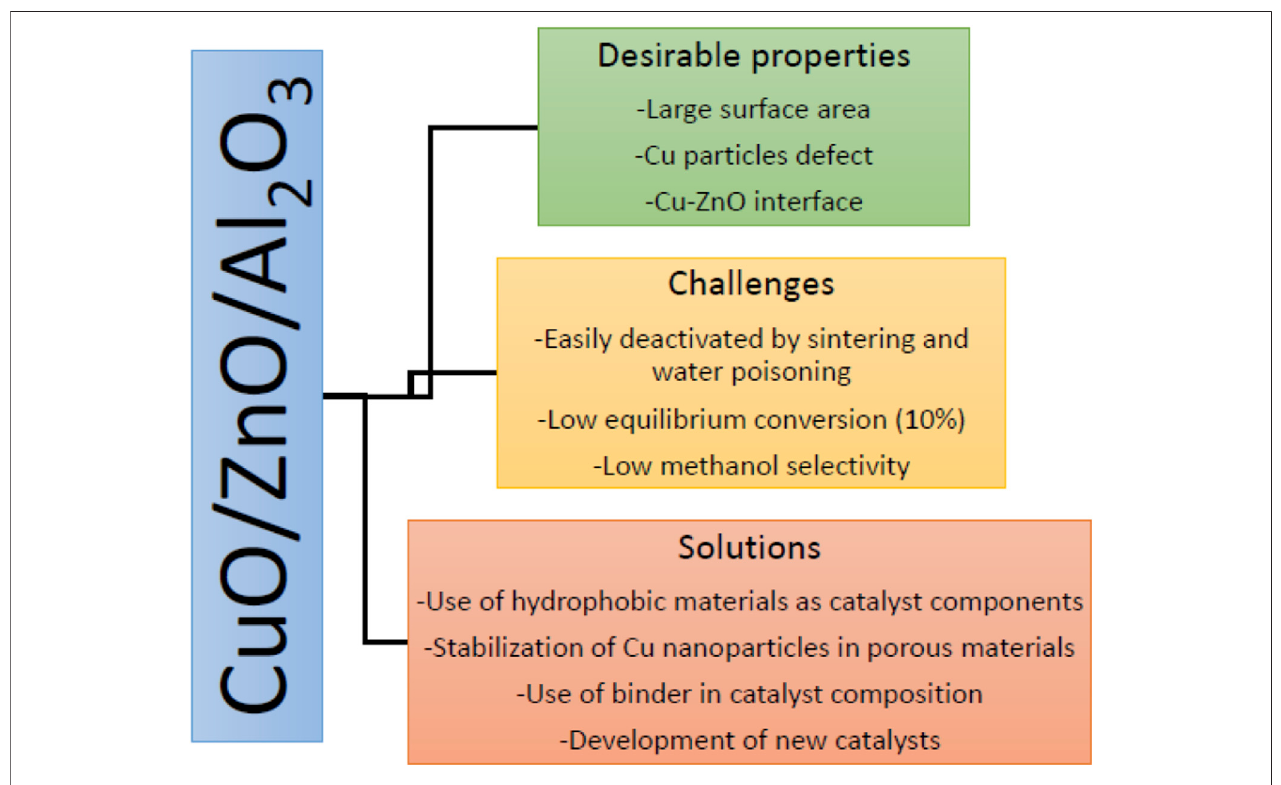
FIGURE 5 | Properties, challenges and possible solutions.